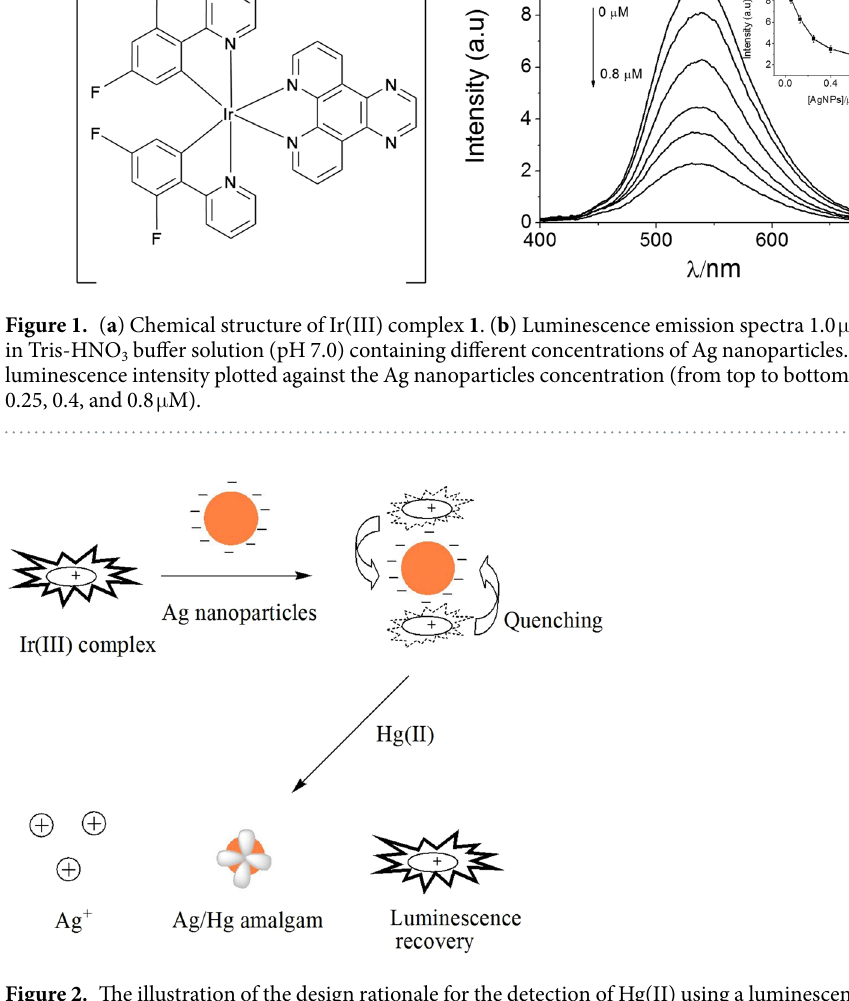
Figure 2. The illustration of the design rationale for the detection of Hg(II) using a luminescent sensor based on Ir(III) complex and Ag